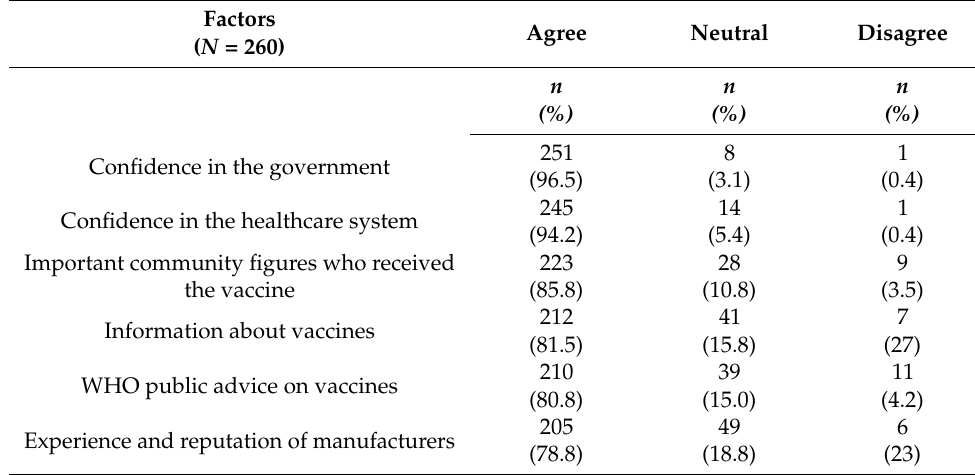
Table 2. Factors influencing trust toward the COVID-19 vaccines provided in Saudi Arabia.